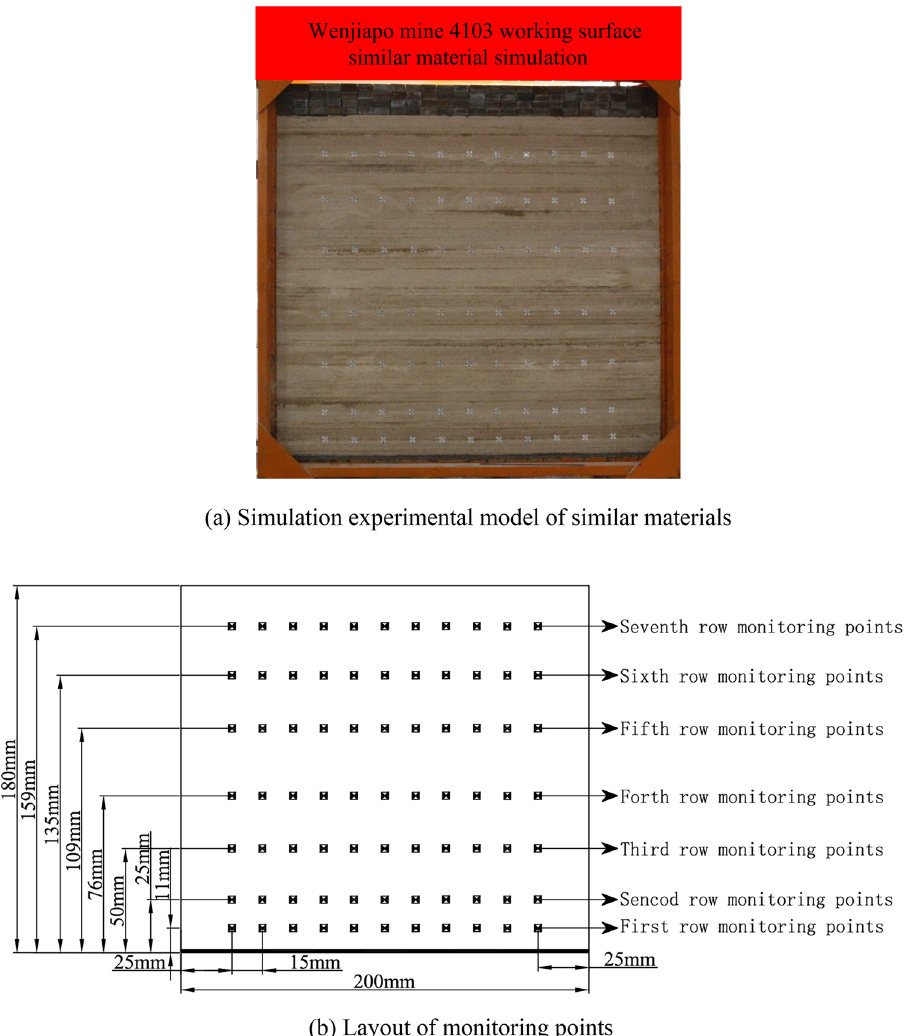
Figure 9. Similar material simulation experiment and monitoring scheme.